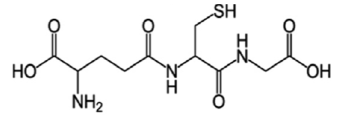
Figure 7. The supplementation of mushroom antioxidants to counteract the ROS/RNS in aging. In this regard, it is worth highlighting that most of the studies conducted to date on in vitro and in animal models that demonstrate the neuroprotective properties of mush- rooms have been conducted on mushroom polysaccharides [169] (Table 1). Cheng et al. [192] showed that polysaccharides puri fi ed by the mushroom Hericium erinaceus exerted protective e ff ects on A β -induced neurotoxicity in PC12 cells through rad- ical scavenging activity, and also reduced ROS production and recovery of mitochondrial function. In another study conducted on glutamatedamaged PC12 cells, Zhang et al. [193] demonstrated that the neuroprotective e ff ect of H. erinaceus was associated with the pro-